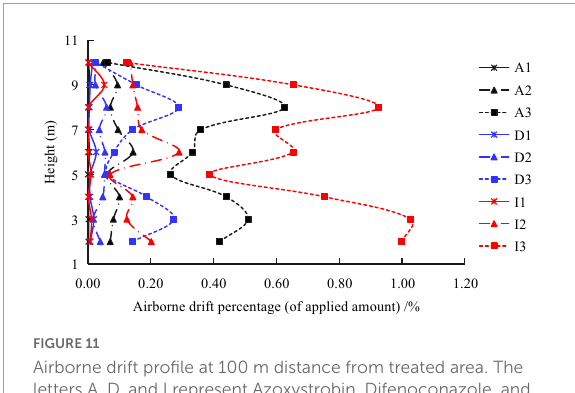
FIGURE11 Airborne drift profile at 100 m distance from treated area. The letters A, D, and I represent Azoxystrobin, Difenoconazole, and Imidacloprid, respectively. The numbers 1, 2, and 3 represent the flight velocity at 1, 2, and 3 m/s, respectively.